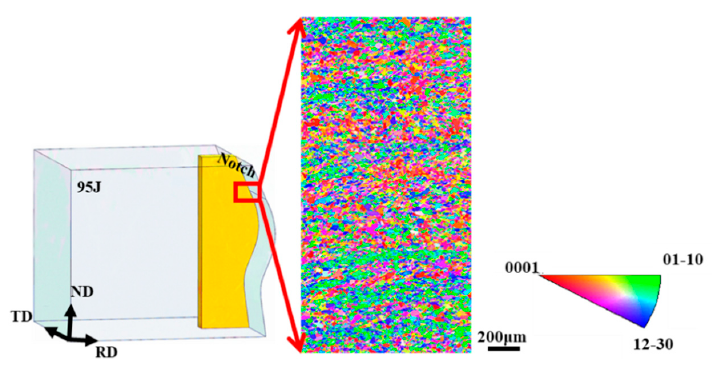
Figure 12. Representative IPF maps of the RD-ND specimen (IPF // TD).